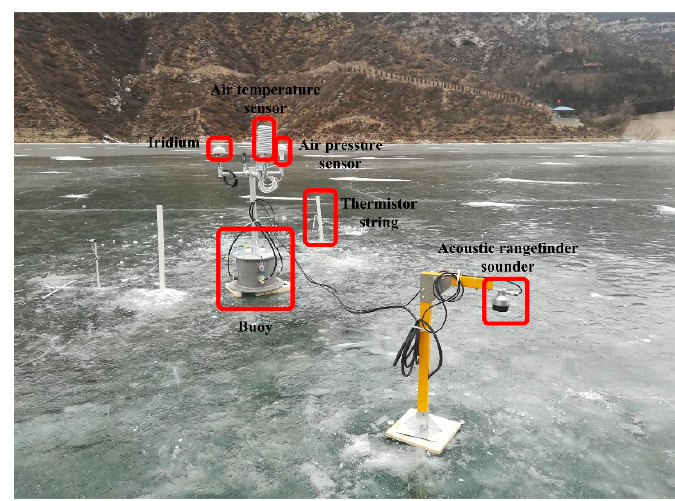
Figure 18. Deployment of the multilayer sea ice temperature sensor system in the second reservoir area of Fen River, Yellow River.